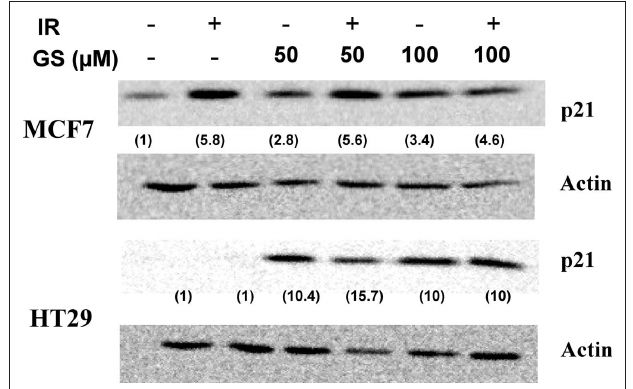
FiguRe 3 | p21 WAF/CiP1 induction post-iR and gS exposure on MCF7 or HT29 cells. Cells were treated with either 50 or 100 μM GS alone for 24 h or with 50 or 100 μM GS for 24 h followed by 6 Gy of IR. Protein was extracted after a 24-h post-IR period. Western analysis was done to determine p21 WAF/CIP1 levels. Blots were stripped and re-probed with actin antibodies for loading controls. Numbers in parenthesis represent the normalized p21 levels determined using actin as the loading control.